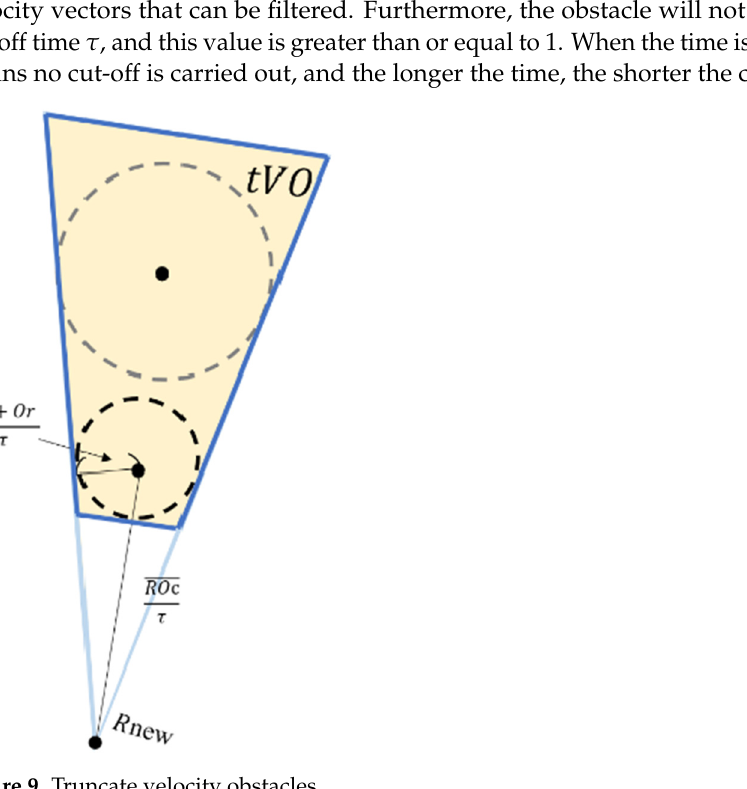
Figure 10. The sequence of robots avoiding obstacles interactively.